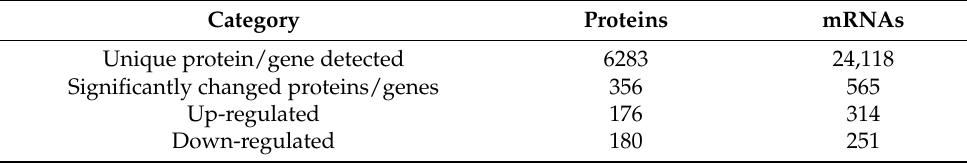
Table 4. Summary of the number of proteins and mRNA detected in WT and odd1